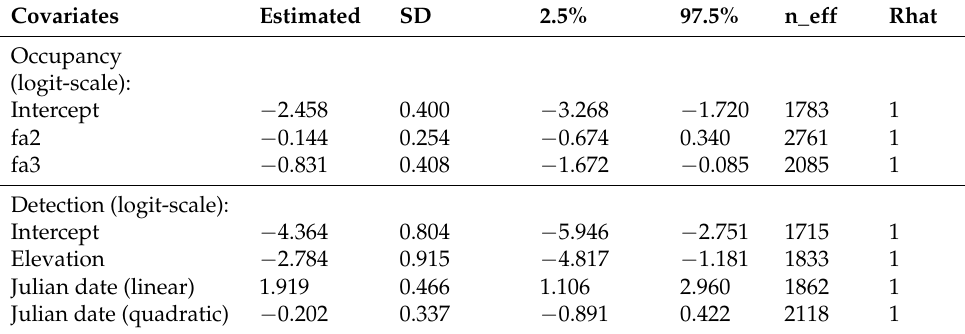
Table A8. Output summary from the second-best occupancy model ( ψ (fa2 + fa3); ρ (intercept + (the top-ranked model did not converge well). Note: fa2 = proportion of forest cover aged between 32 and 54 years; fa3 = proportion of forest cover aged 55 years and older. Runtime: 29.712